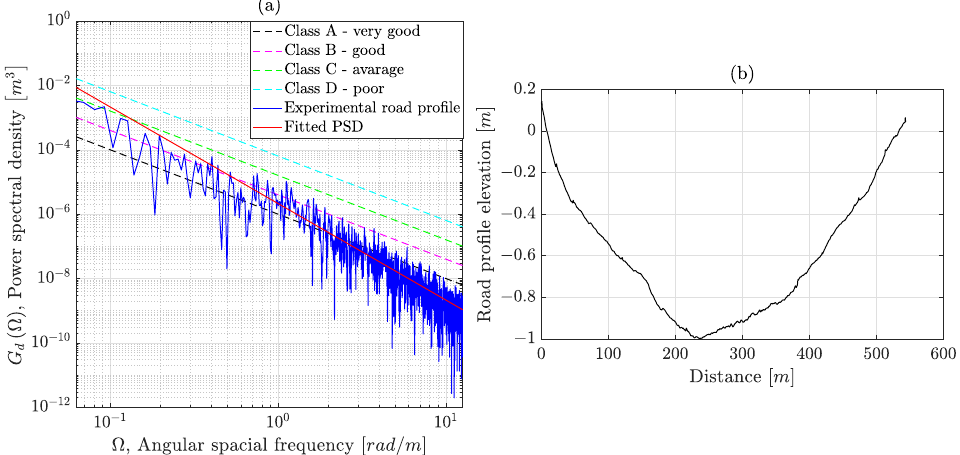
Figure 12. ( a ) Power spectral density of ( b ) experimental road